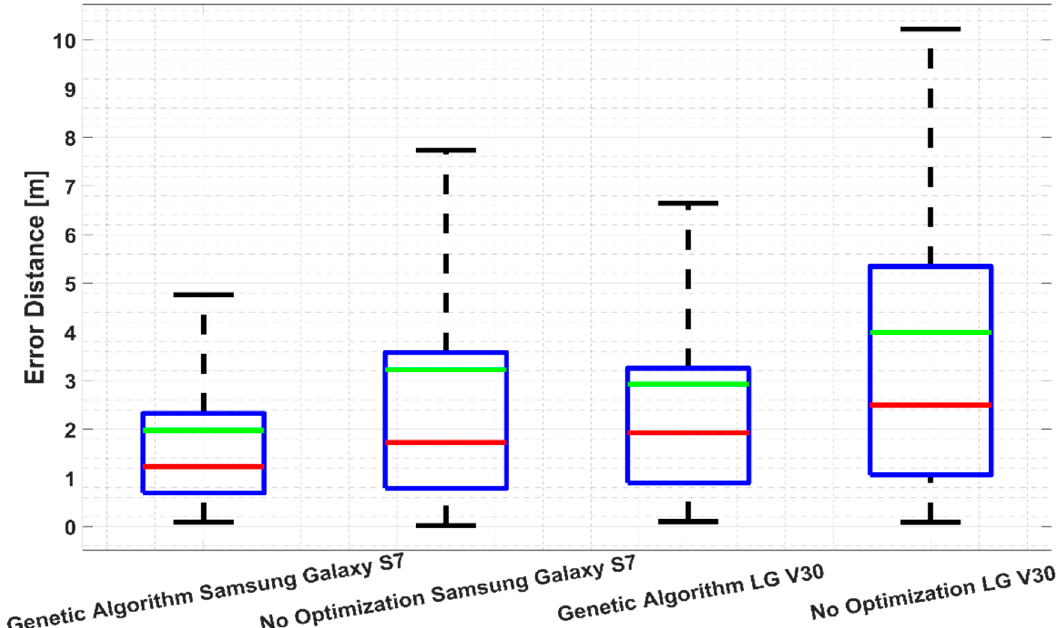
Figure 11. Empirical Cumulative Distribution Function of all evaluation runs for the optimized and knowledge-based parameter variants for the corresponding dataset.